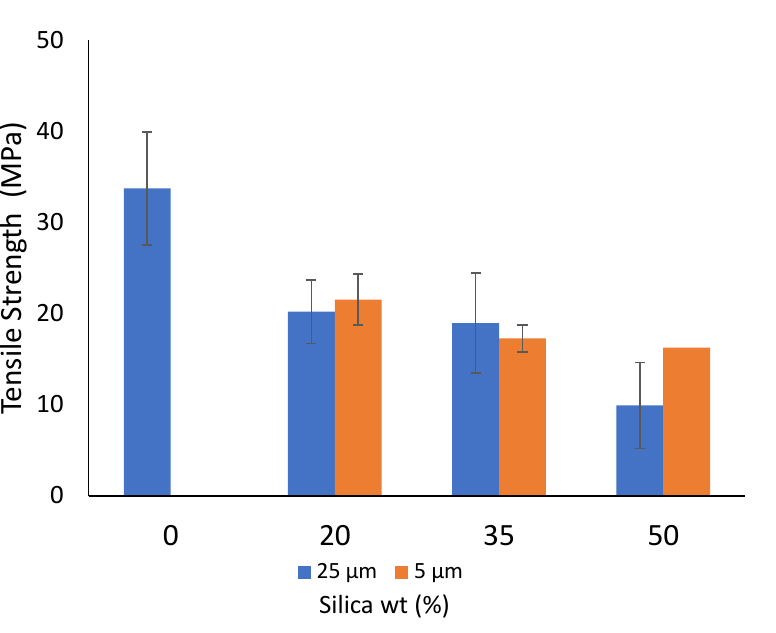
Figure 6. Tensile strength of the prepared composite sheets. Table 6. Mechanical properties of the composite